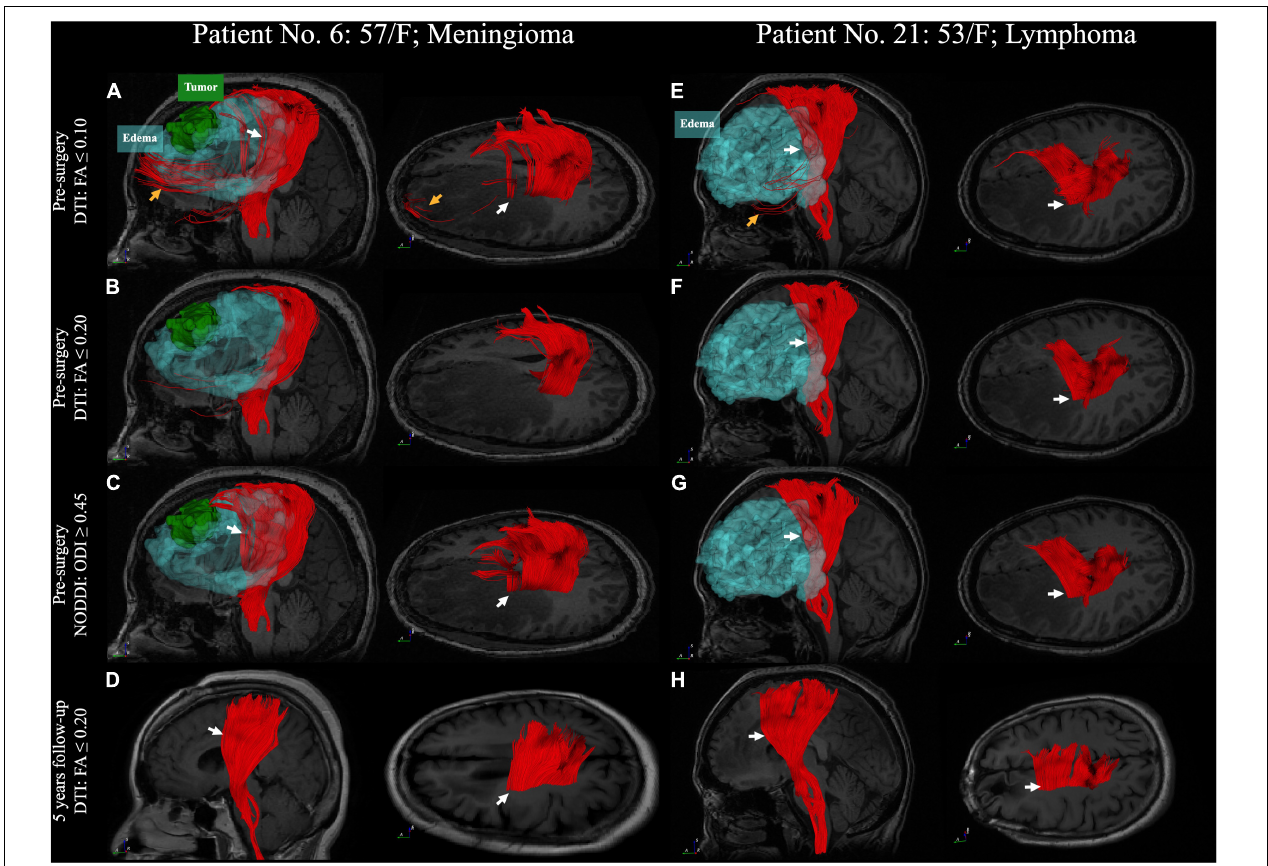
FIGURE 6 | A comparison between DTI and NODDI-derived CST reconstruction with 5 years follow-up. (A–D) Patient No. 6, a 57-year-old woman with a meningioma (WHO grade II) in the left frontal lobe. (E–H) Patient No. 21, a 53-year-old woman with malignant B-cell lymphoma. DTI tractography with standard termination criteria (FA ≤ 0.2) has failed to reconstruct the CST in the region with peritumoral edema in the first case. (B) However, the CST has been successfully reconstructed in the second case ( F , white arrow). DTI tractography with low FA criteria (FA ≤ 0.1) displays better performance in the region with peritumoral edema (white arrow). Nonetheless, it is accompanied by noisy streamlines ( A,E , yellow arrow). NODDI-derived tractography with ODI reveals better performance in the region with edema and less noisy streamlines ( C,G , white arrow). The DTI tractography with standard termination criteria reveals a CST similar to the pre-surgery NODDI-derived CST after the vasogenic edema has subsided in 5 years (D,H) . DTI, diffusion tensor imaging; FA, fractional anisotropy; NODDI, neurite orientation dispersion and density imaging; CST, corticospinal tract; WHO, World Health Organization and ODI, orientation dispersion